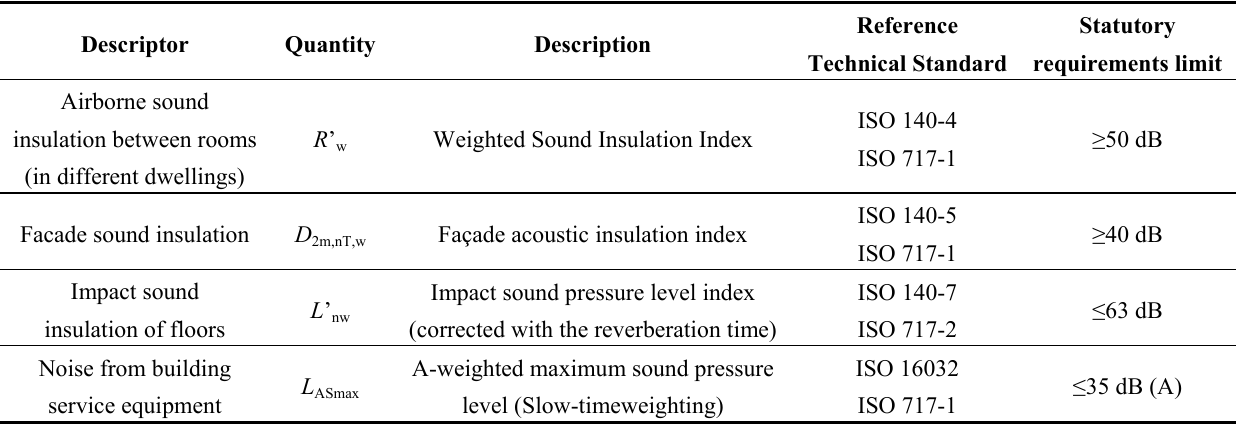
Table 3. Main descriptors and limit values [50].